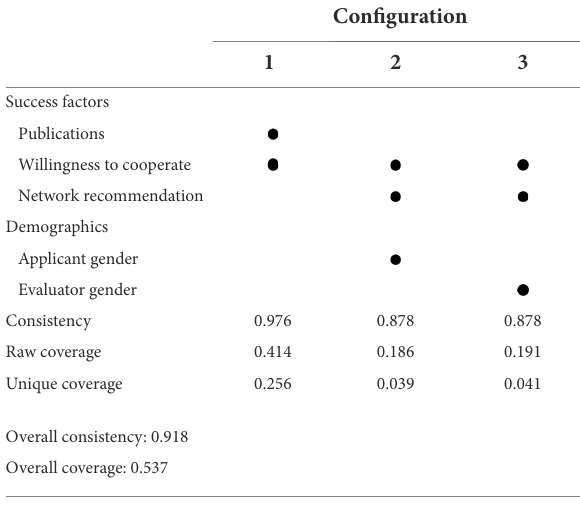
TABLE 2 Configurations leading to high selection recommendation.